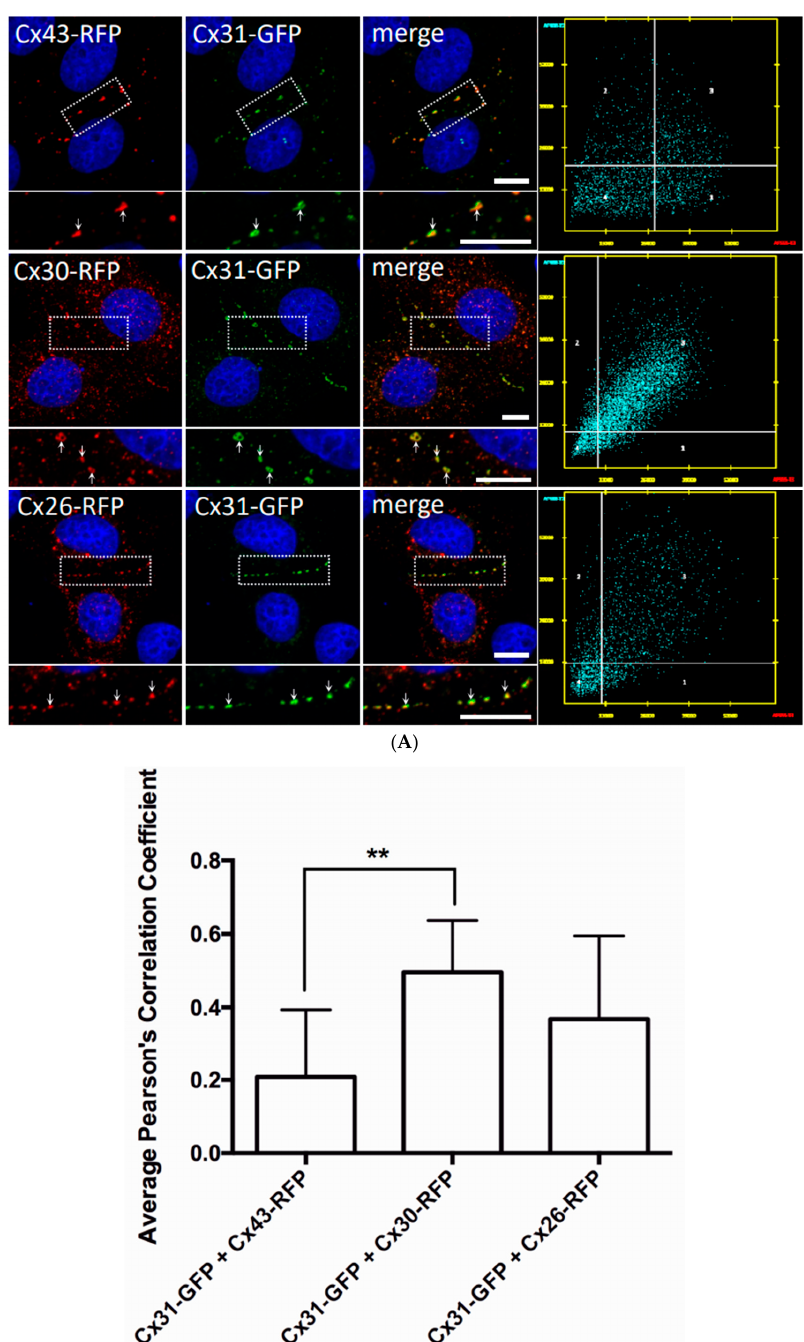
Figure 7. Cx31 colocalized better with Cx30 compared to Cx43. ( A ) REKs were engineered to co-express Cx31-GFP with either Cx43-RFP, Cx30-RFP or Cx26-RFP and assessed for colocalization using the Pearson’s correlation coe ffi cient. Higher magnification inserts images revealed that Cx31 was co-assembling into gap junctions that also contained Cx30 and Cx26 (note yellow, arrows) while Cx43 more often appeared adjacent to Cx31 gap junction plaques (arrows). Nuclei were stained with Hoechst dye. Bars = 10 µ m. ( B ) Quantification of colocalization patterns revealed that Cx31 was significantly more colocalized with Cx30 than with Cx43. ** p < 0.01, data plotted as ±